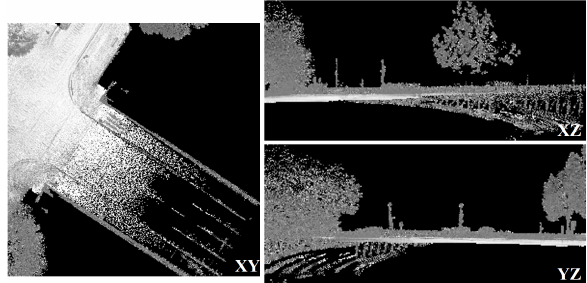
The images that show the normal vectors’ at the Z direction il- lustrate brighter values when a normal vector points towards the Z direction. In contrast, they illustrate darker values when the surfaces are not perpendicular to the Z direction.